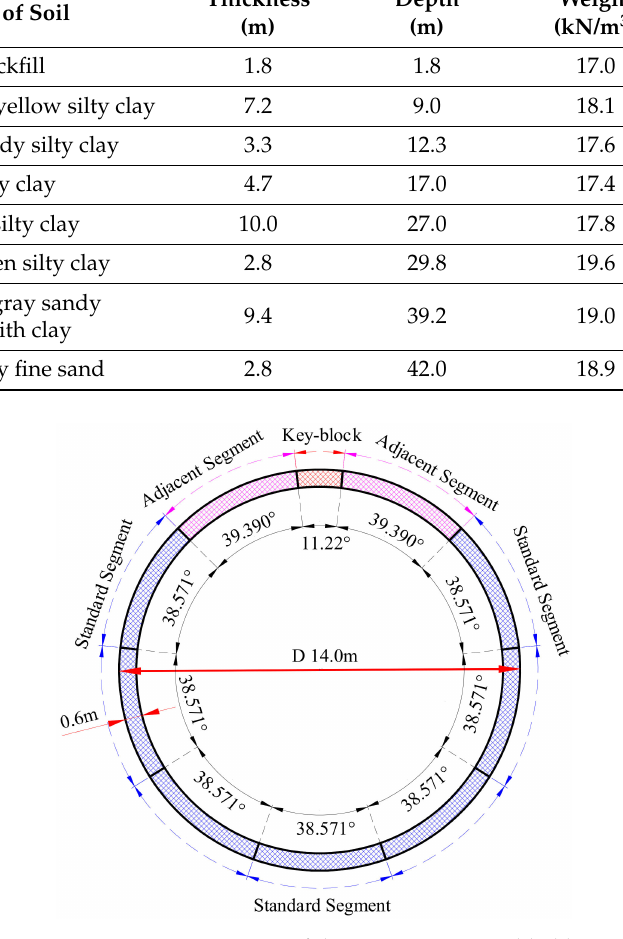
Figure 1. Cross-section of the prototype assembled